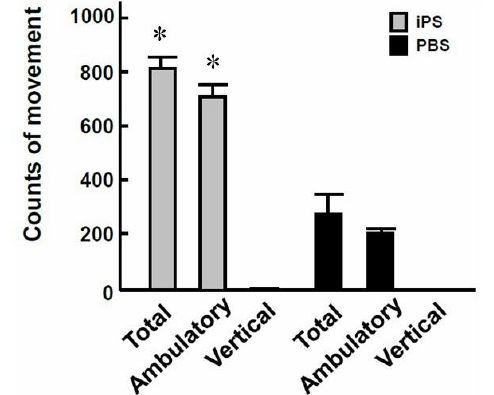
Figure 6. Effect of intraperitoneal cell transplantation on motor activity in CCl mice and tumorigenesis. CCl -treated mice were injected with PBS or transplanted with 4 3-genes iPSCs (2 × 10 6 cells) via an intraperitoneal route to determine motor movements. Motor activities in an open field were determined by using the Opto-Varimex animal activity meter. Data are the mean ± SD of six independent experiments. * P < 0.05 vs .